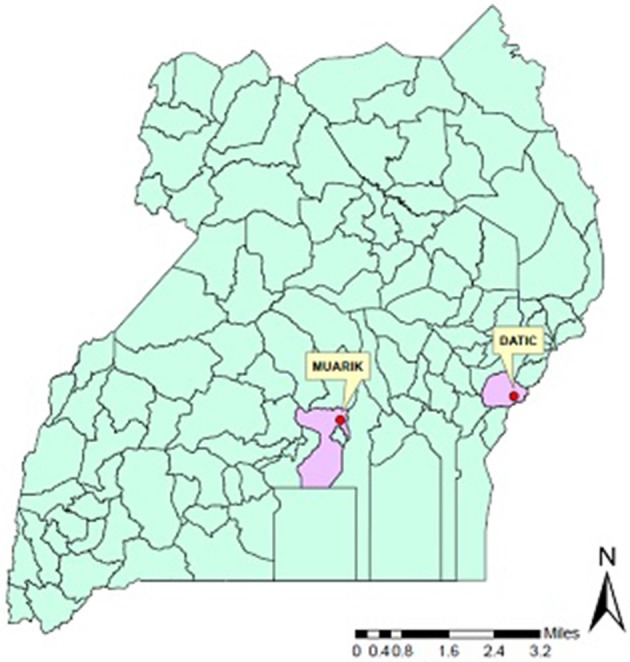
A map of Uganda showing the location of DATIC and MUARIK experimental sites.